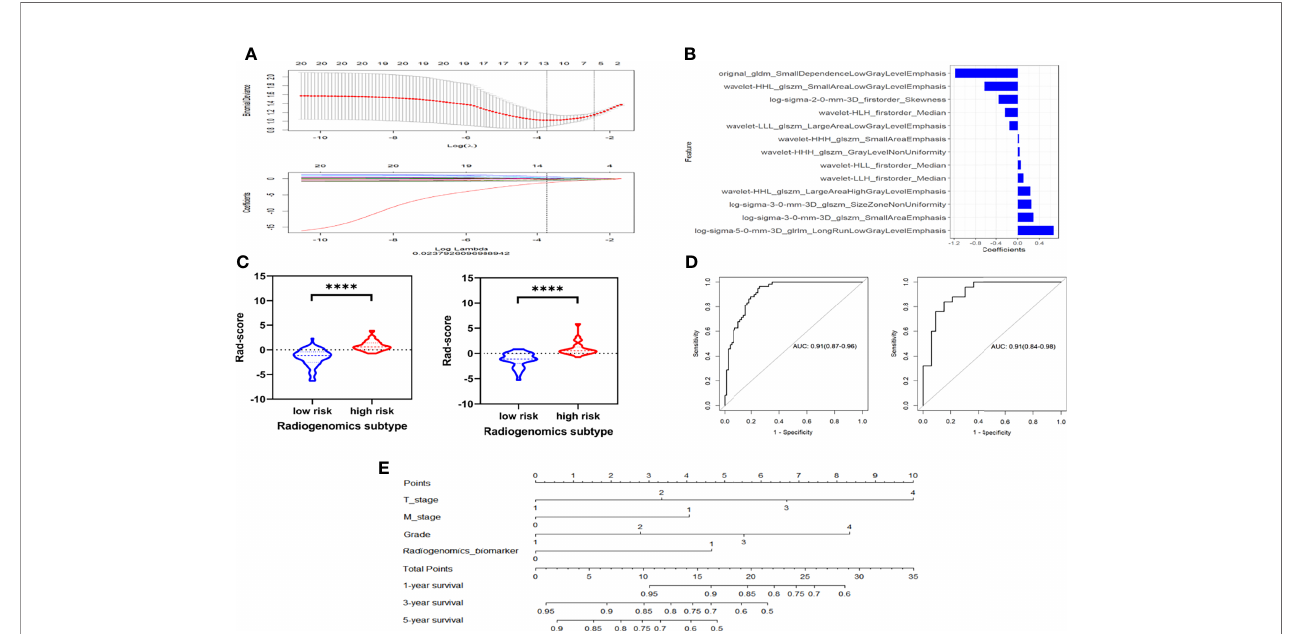
FIGURE 5 | The Lasso regression procedure to select the optimist radiomics features (A) . Features selected for hypoxia-related radiogenomics model construction (B) . The violin plots of the radiogenomics model in the training cohort and the validation cohort (C) . ROC curves shows that the radiogenomics biomarker could exactly distinguish patients into high- an low- hypoxia-related genomics grouping both in the training cohort and validation cohort (D) . (E) Nomogram of the model incorporating radiogenomics marker and other effective clinical and pathological information through Cox regression. ****p < Details of the included radiomics features are shown in Figure 5B . The speci fi c formulae for radiogenomics scores are presented in Supplementary Materials III .